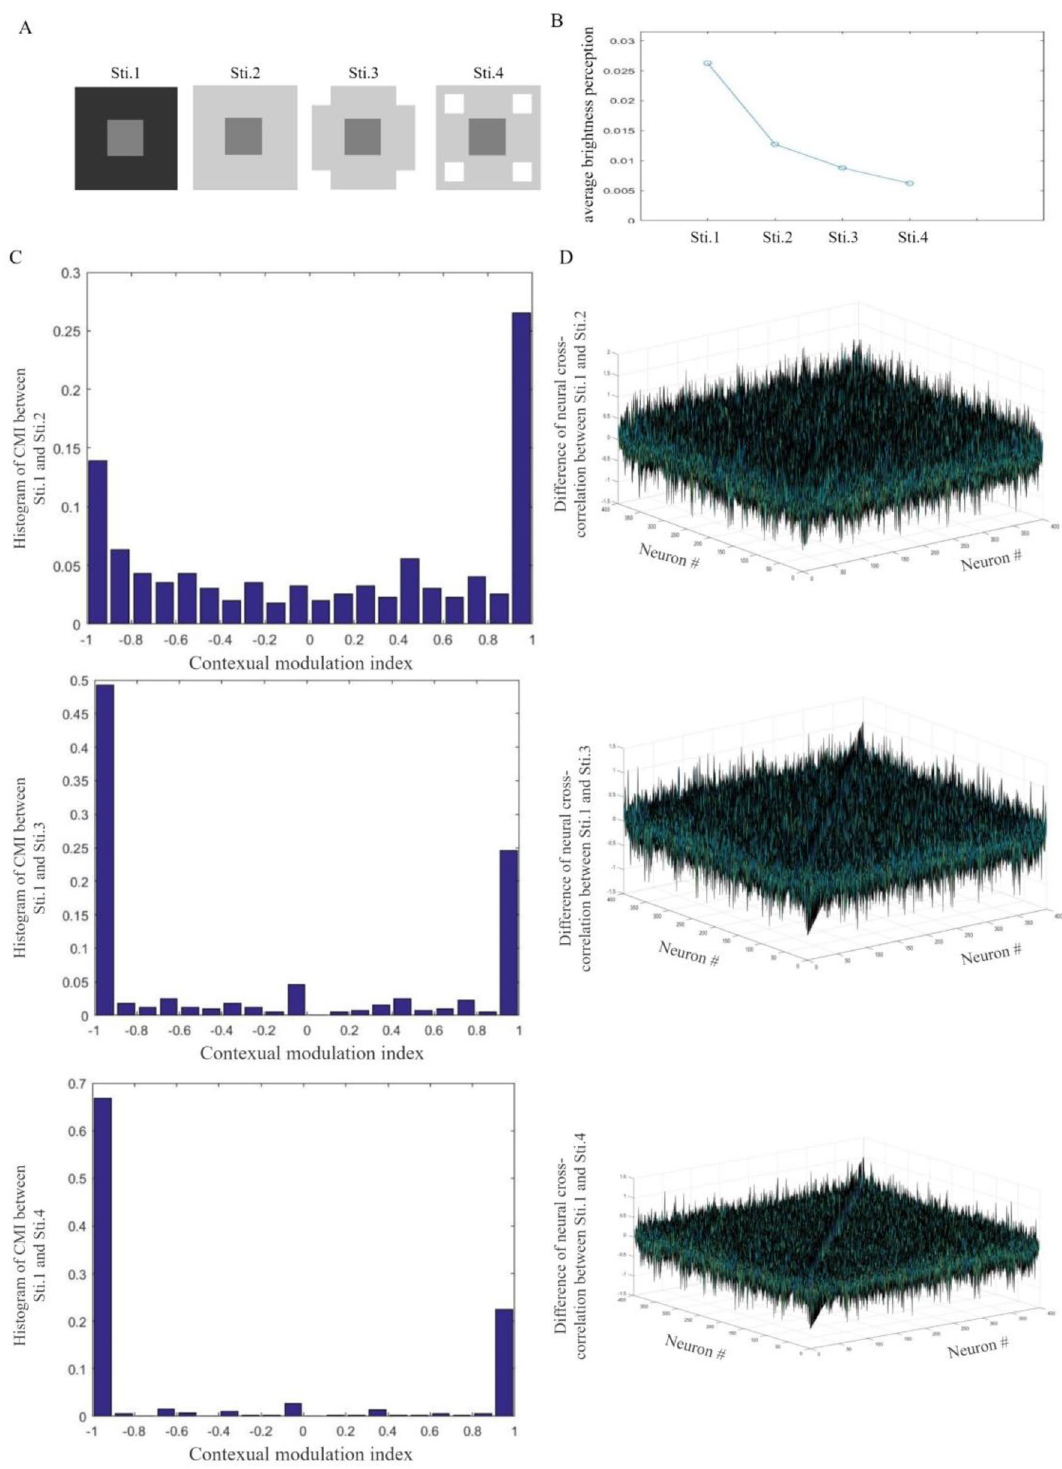
Figure 3. Brightness perception induced by distances between distractors and targets. ( A ) Images used as visual stimuli in our simulations. ( B ) Averaged brightness perception of target squares. For designed stimuli, distractors with a shorter distance induce darker brightness perception of the target. ( C ) The histogram of excitatory neural CMIs to stimuli. A non-zero CMI indicates the neural responding modification induced by the varying distance between distractors and the target. For a neural population, the histogram of CMIs reflects contextual modulation of neural responses. For designed stimuli, distractors with a shorter distance can induce larger neural responding modulations. ( D ) Difference of excitatory neural responding cross-correlation to stimuli. A non-zero difference indicates the modulation of neural interactions induced by the varying distance. With simulations of Sti. 1 for comparison, different amplitudes of neural interactive modification reflect influences of the varying